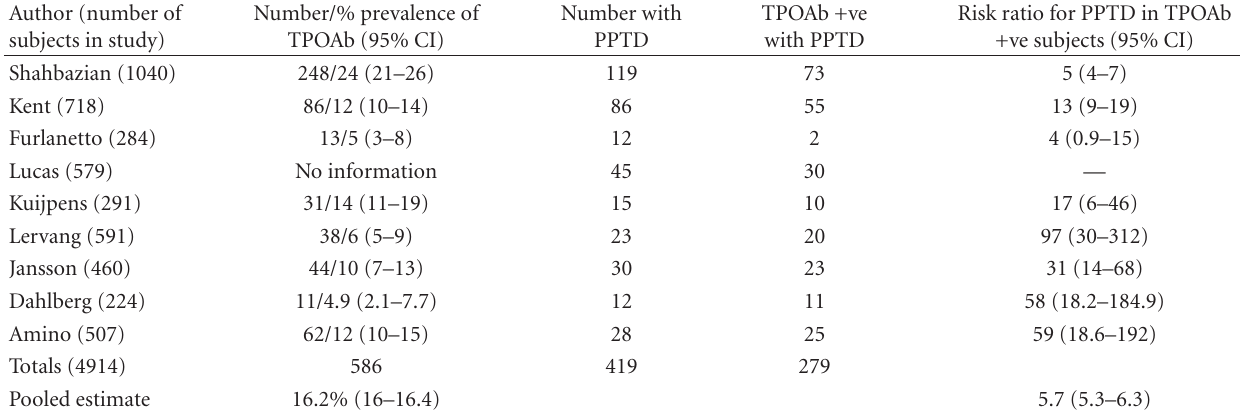
Table 1: TPOAb prevalence and the risk of developing PPTD (adapted from [4] with permission).